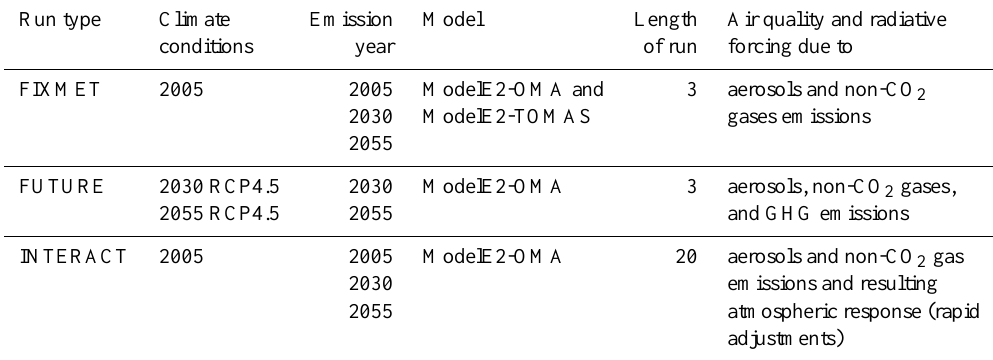
Table 1. Summary of simulations used in this